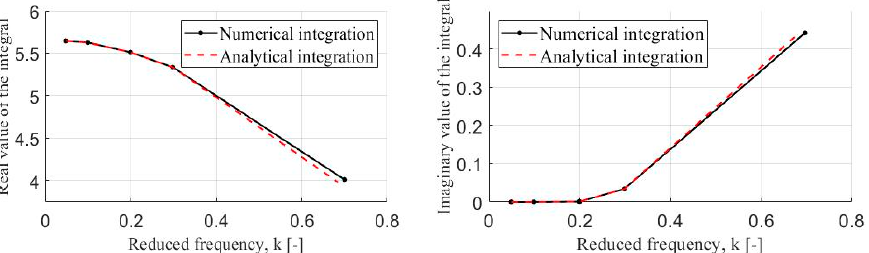
Figure 3. Comparison of numerical and exact integration of singular terms of the kernel for low frequencies.